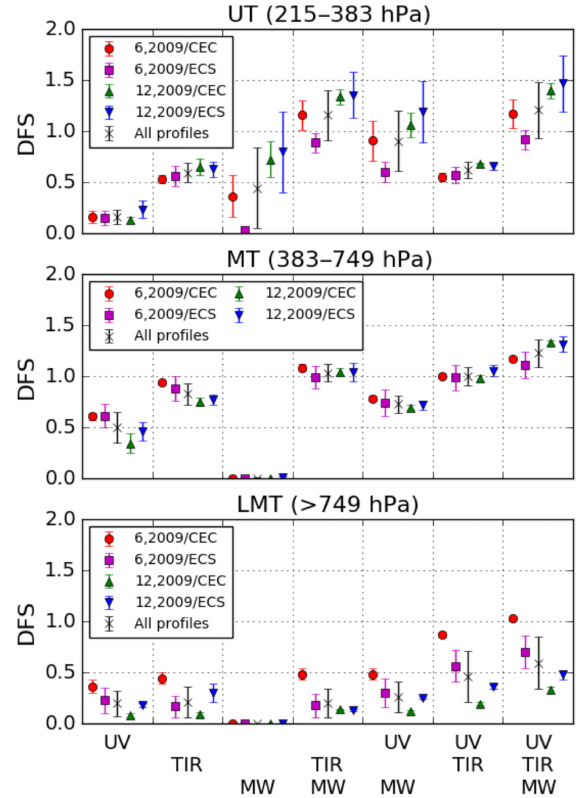
Figure 3. Values of DFS for upper troposphere (UT, 215–383hPa), middle troposphere (MT, 383–749hPa), and lowermost troposphere (LMT, > 749hPa): CEC in June 2009 (red), ECS in June 2009 (purple), CEC in December 2009 (green), ECS in December 2009 (blue), and 20 profiles averaged